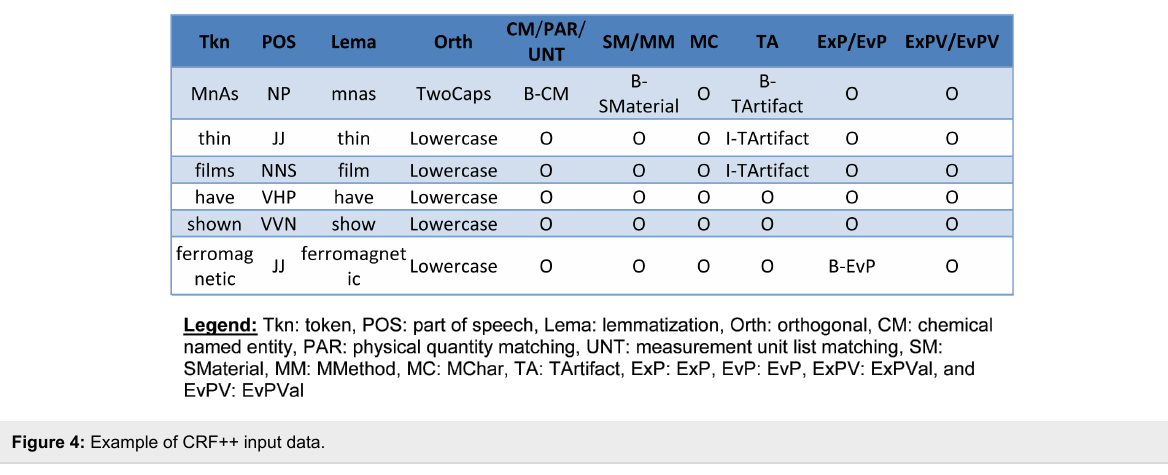
The input for the CRF++ tool is in IOB format, which identi- fies the position (beginning, inside, out of) of a token of text related to a term. Figure 4 shows an example of input data for the CRF++